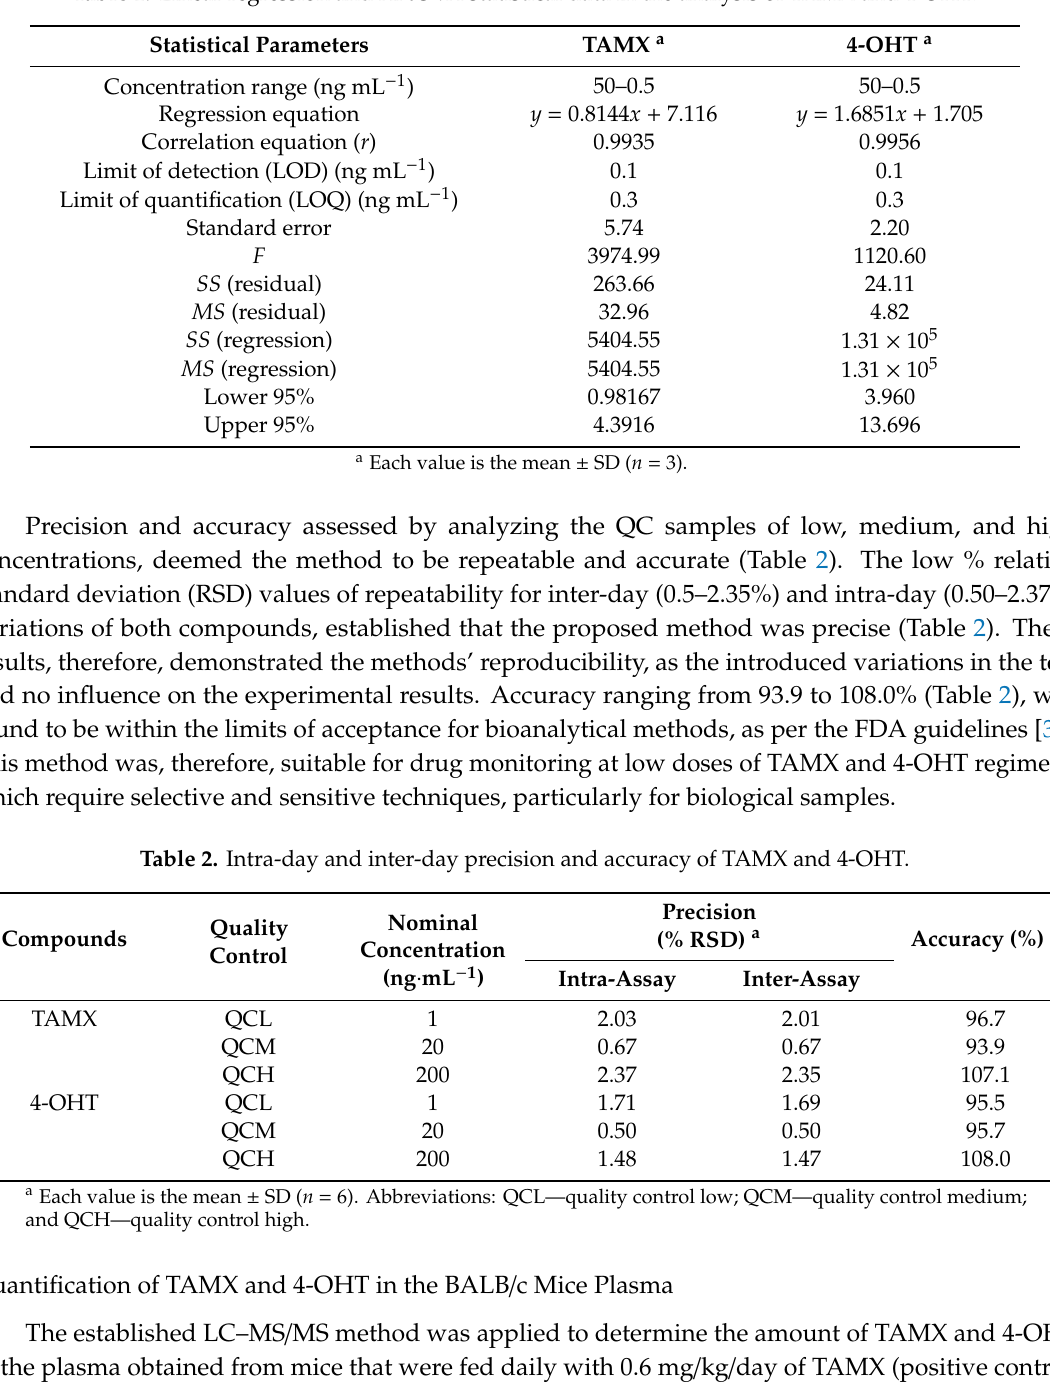
Table 1. Linear regression and ANOVA statistical data in the analysis of TAMX and 4-OHT.